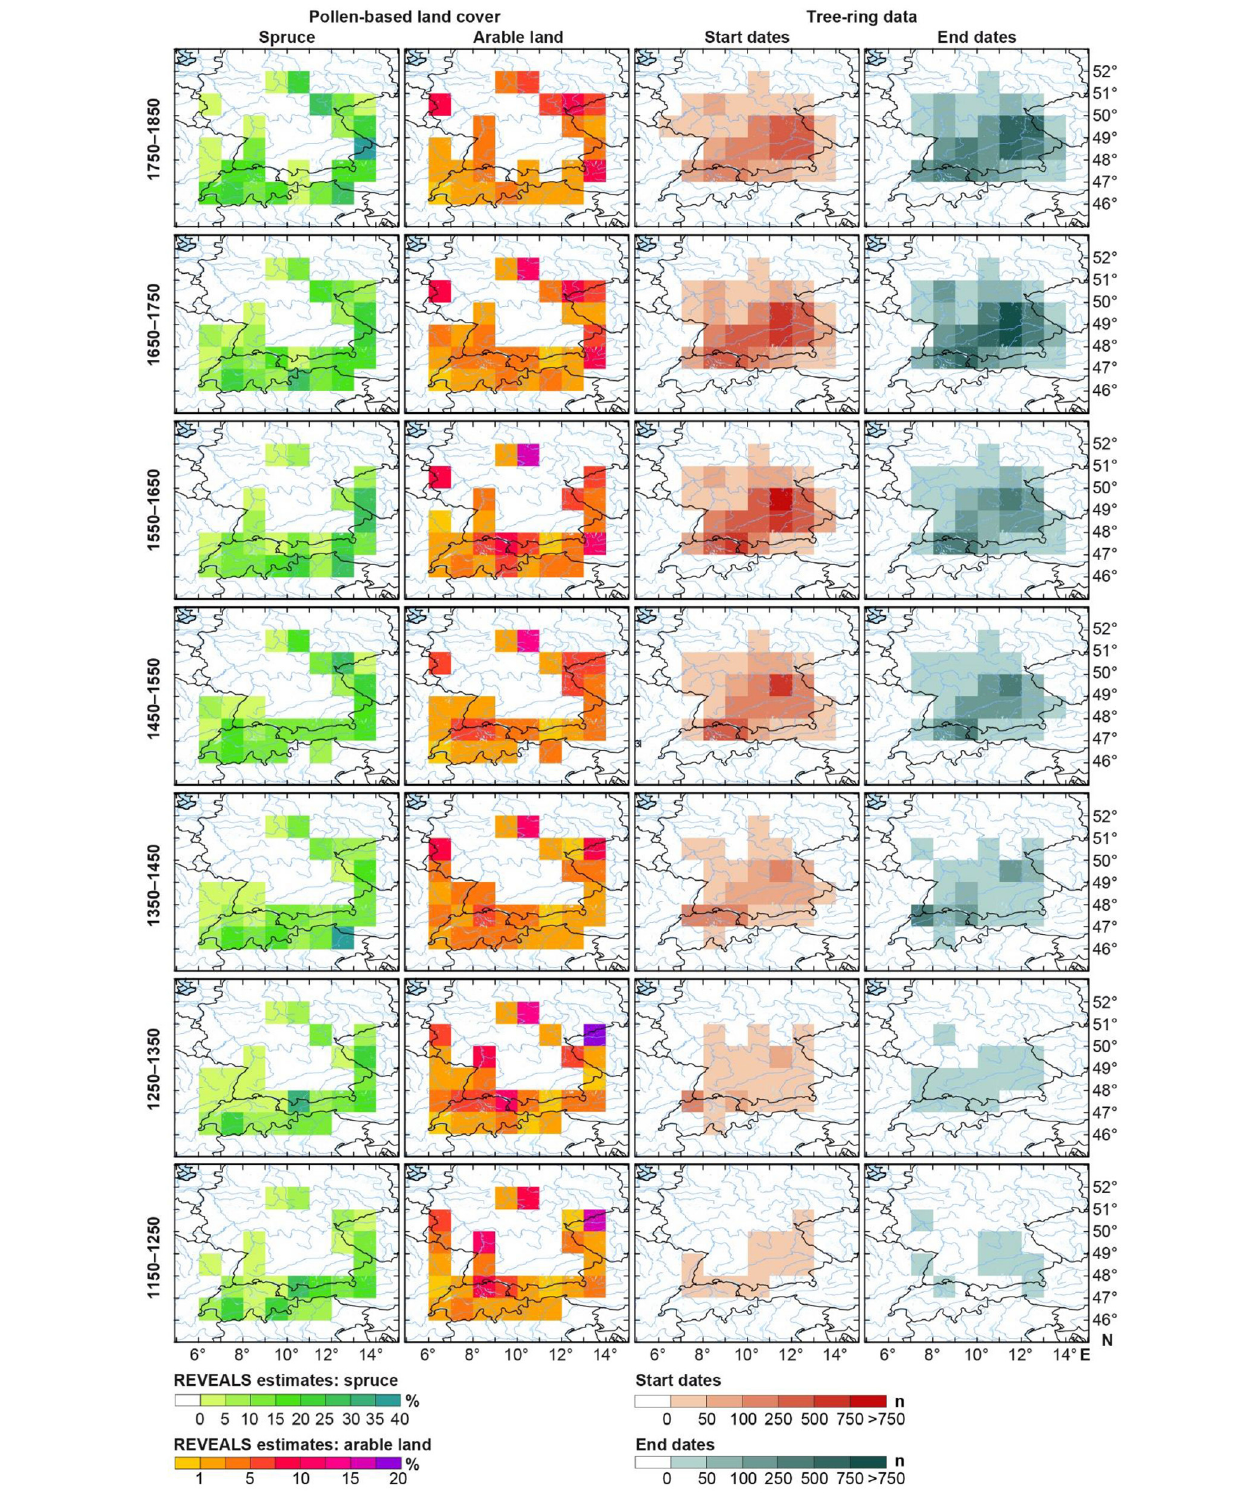
FIGURE 4 | Gridded maps for seven 100-year periods from 1150 to 1850 showing regional abundance of spruce (REVEALS, left ) in comparison to the regional abundance of arable land (REVEALS, second left ), and the establishment of spruce trees in forests based on start dates (second right) and its utilization in buildings based on end dates (right)